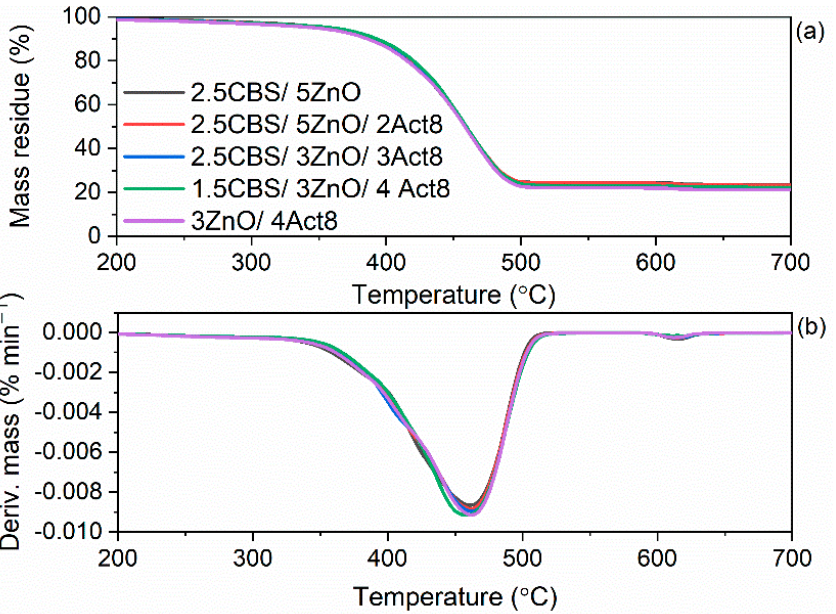
Figure 10. Thermogravimetric (TG) and Derivative Thermogravimetric (DTG) curves of SBR vulcanizates containing CBS: ( a ) TG curves; ( b ) DTG curves.